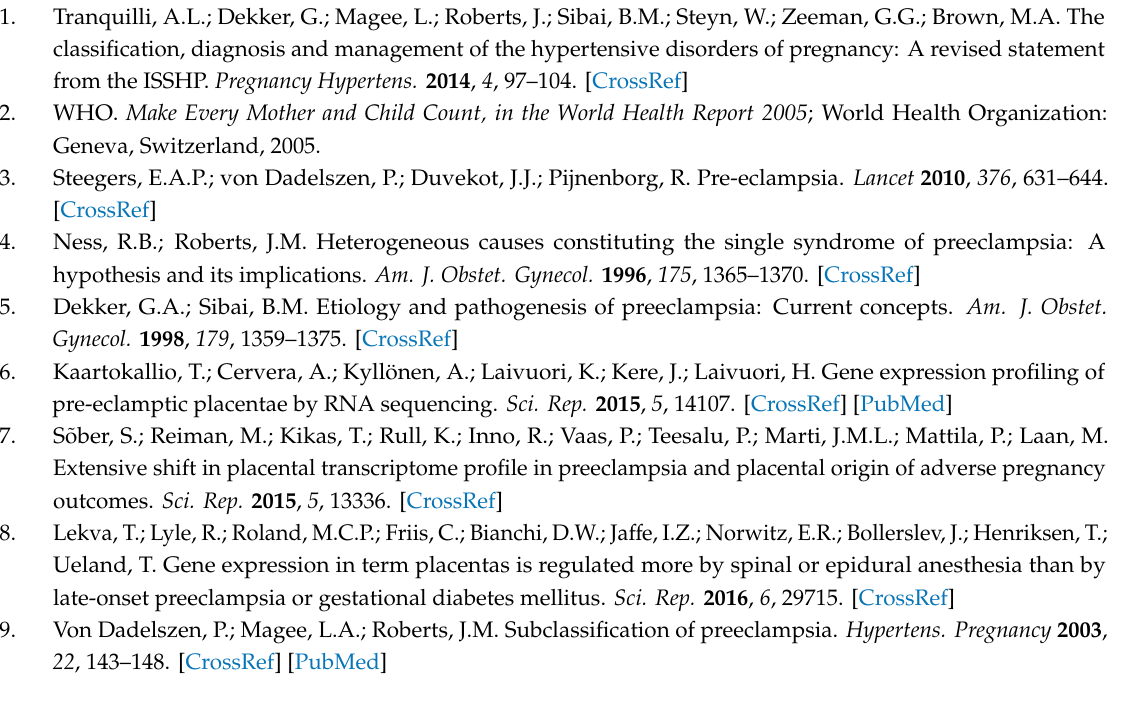
Supplementary Materials: The following are available online at http: // www.mdpi.com / 2079-7737 / 9 / 4 / 62 / s1, Figure S1: Gene Ontology Term of upregulated di ff erentially expressed genes. Figure S2: Gene Ontology Term of downregulated di ff erentially expressed genes. Table S1: Gene Ontology of Upregulated Genes. Table S2: Gene Ontology of Downregulated